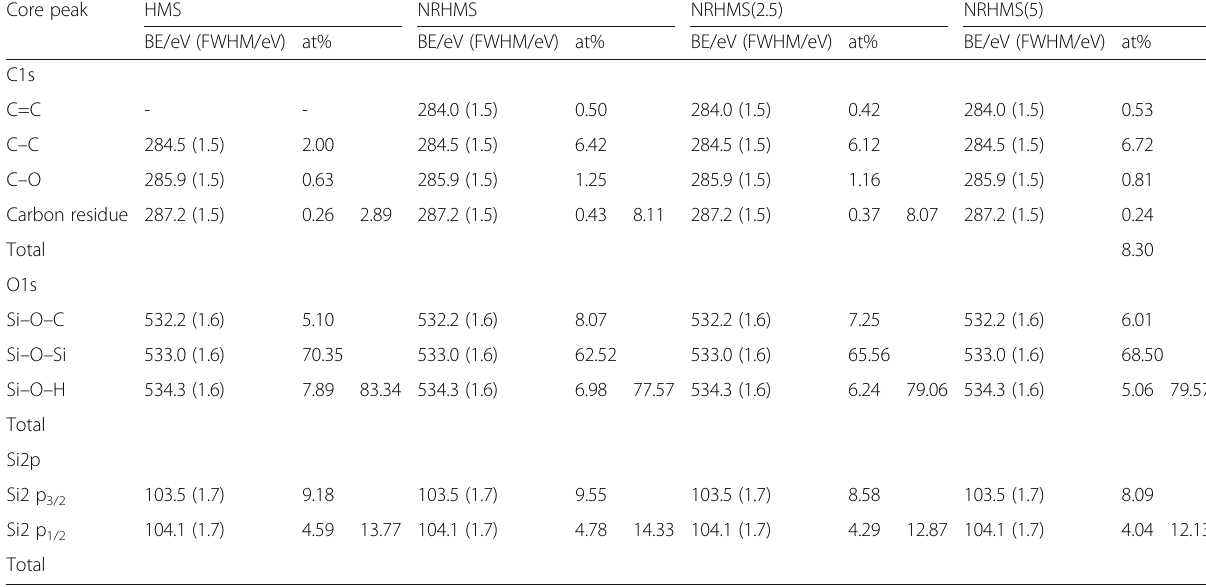
Table 2 XPS binding energies and atomic percentage for the C1s, O1s, and Si2p core peaks of HMS and the NRHMS nanocomposites Core